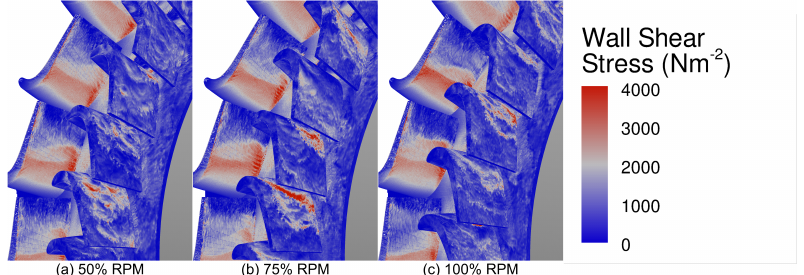
Figure 23. Instantaneous wall shear stress on stator and rotor surface for: ( a ) 50% RPM; ( b ) 75% RPM; and ( c ) 100% RPM.